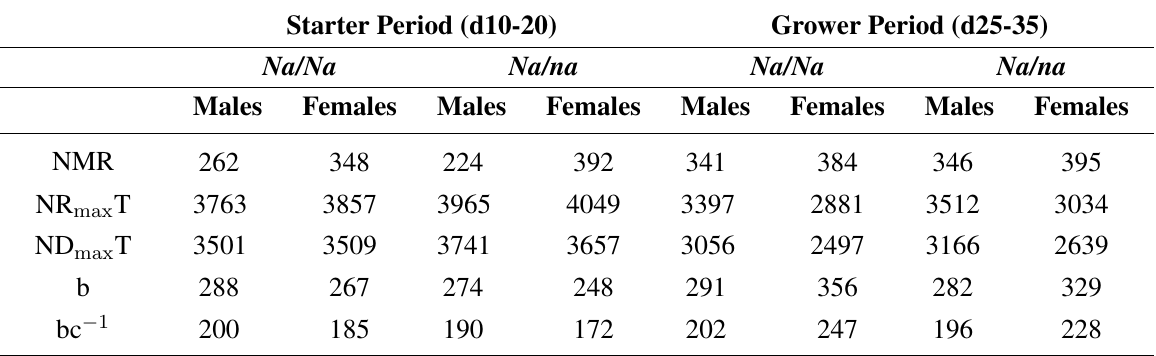
Table 3. Model parameters as derived from N balance experiments with fast growing naked neck chicken depending on age period, genotype and sex